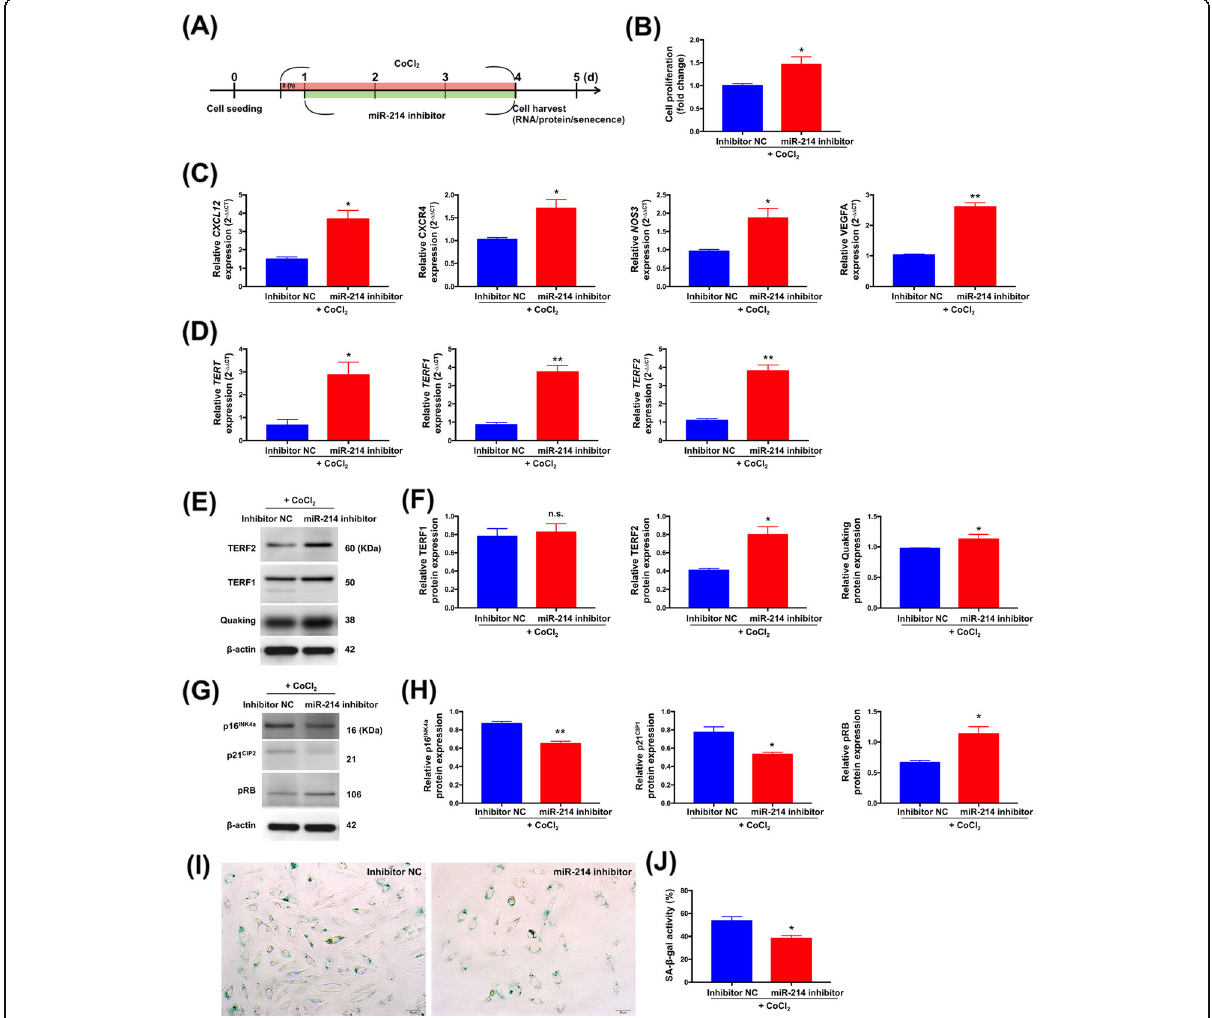
Fig. 5 MicroRNA-214-3p (miR-214) antagomiR in rat vascular smooth muscle cells (A7r5) induced angiogenesis and proliferation but suppressed senescence. a Schematic of the protocol for transfection of A7r5 VSMCs with a miRNA antagomiR control (antagomiR NC) or a miR-214 antagomiR and processed at the indicated times. b The effects of miR-214 antagomiR on VSMC cell proliferation were tested by CCK-8 assay. c Angiogenetic mRNA expression levels of NOS3, VEGFA, CXCL12 and CXCR4 compared in cells transfected with antagomiR NC or miR-214 antagomiRs ( n = 3). d Senescence-associated mRNA expression of TERT, TERF1 and TERF2 compared in cells transfected with antagomiR NC or miR-214 antagomiRs ( n = 3). e , G Representative western blots depicting TERF1, TERF2, p16 INK4 , p21 CIP1 , pRB, and quaking expression in antagomiR NC or miR-214 antagomiRs transfected cells. f , h Normalized expression of TERF1, TERF2, p16 INK4 , p21 CIP1 , pRB, and quaking ( n = 3). i Senescence- associated β -galactosidase staining demonstrating senescence in SCR or miR-214 transfected cells. j Bar graphs show quantification of relative of SA- β -gal positive cells ( n = 3). Data are presented as the means± SEM. * P < 0.05; ** P < 0.01; ns, non-significance (Two-tailed Student ’ s